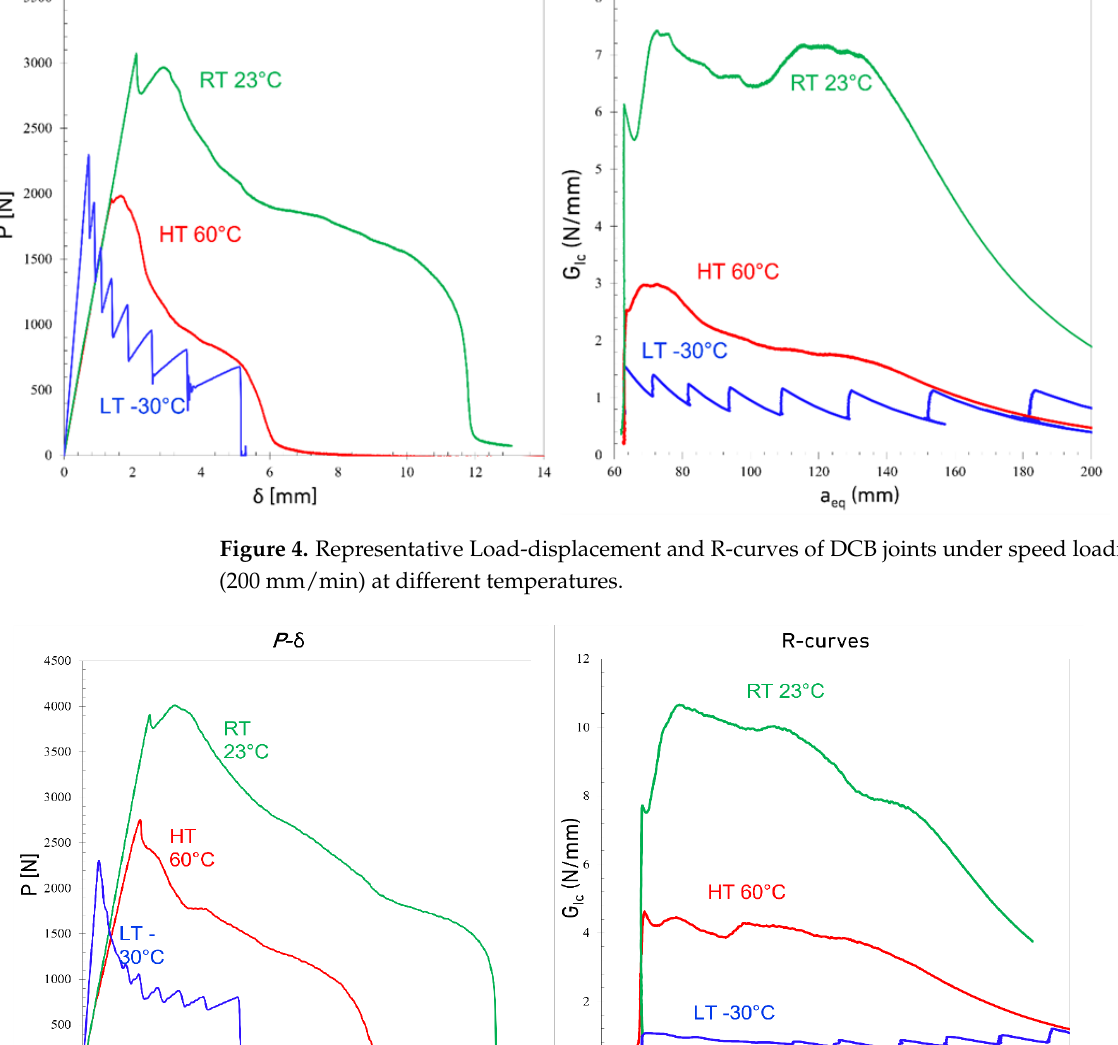
Figure 3 . Representative Load-displacement and R-curves of DCB joints under quasi-static loading rates (0.2 mm/min) at different temperatures .